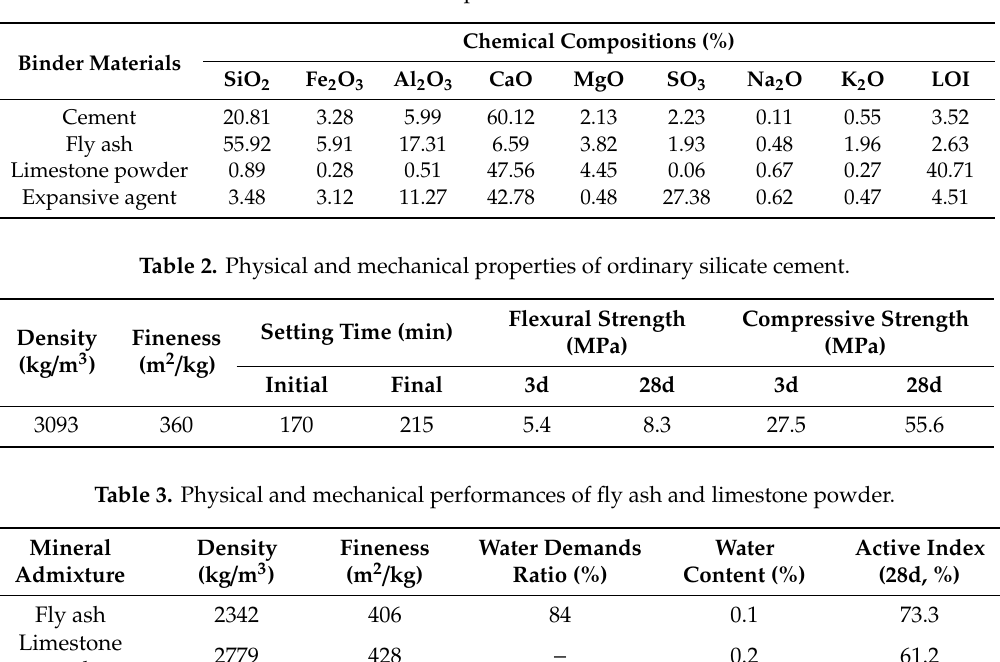
Table 1. Chemical compositions of binder materials.